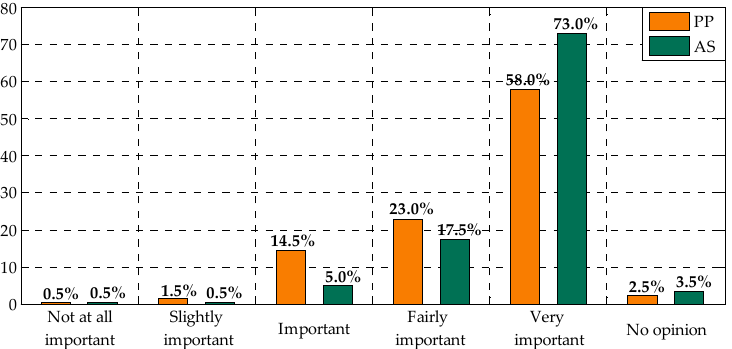
Figure 9. Local Public (LP) views (%) on the importance of Public Participation (PP) in the RETs’ site-selection processes and of Appropriate Sites (AS) for RETs.